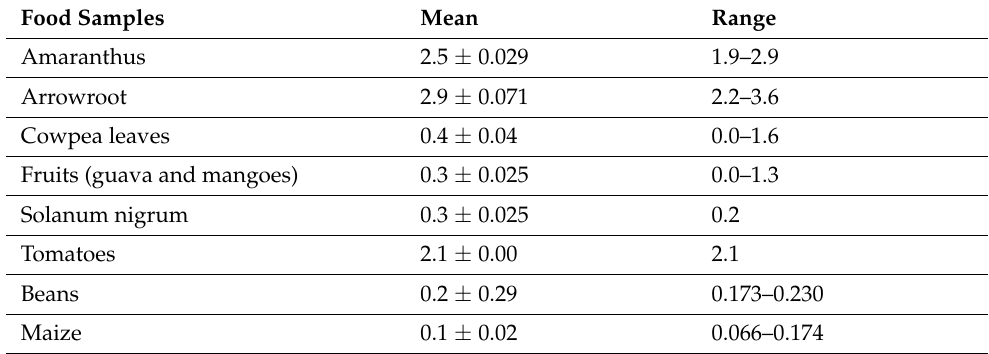
Table 1. Lead concentrations in some food items ( µ